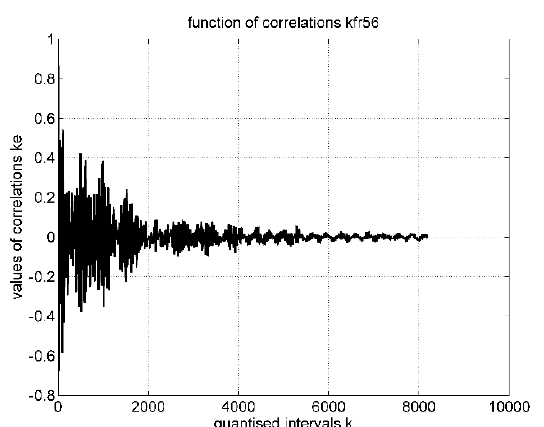
Figure 11. Normalized inter-covariance function of the 3th and 4th vibration accelerations vectors.